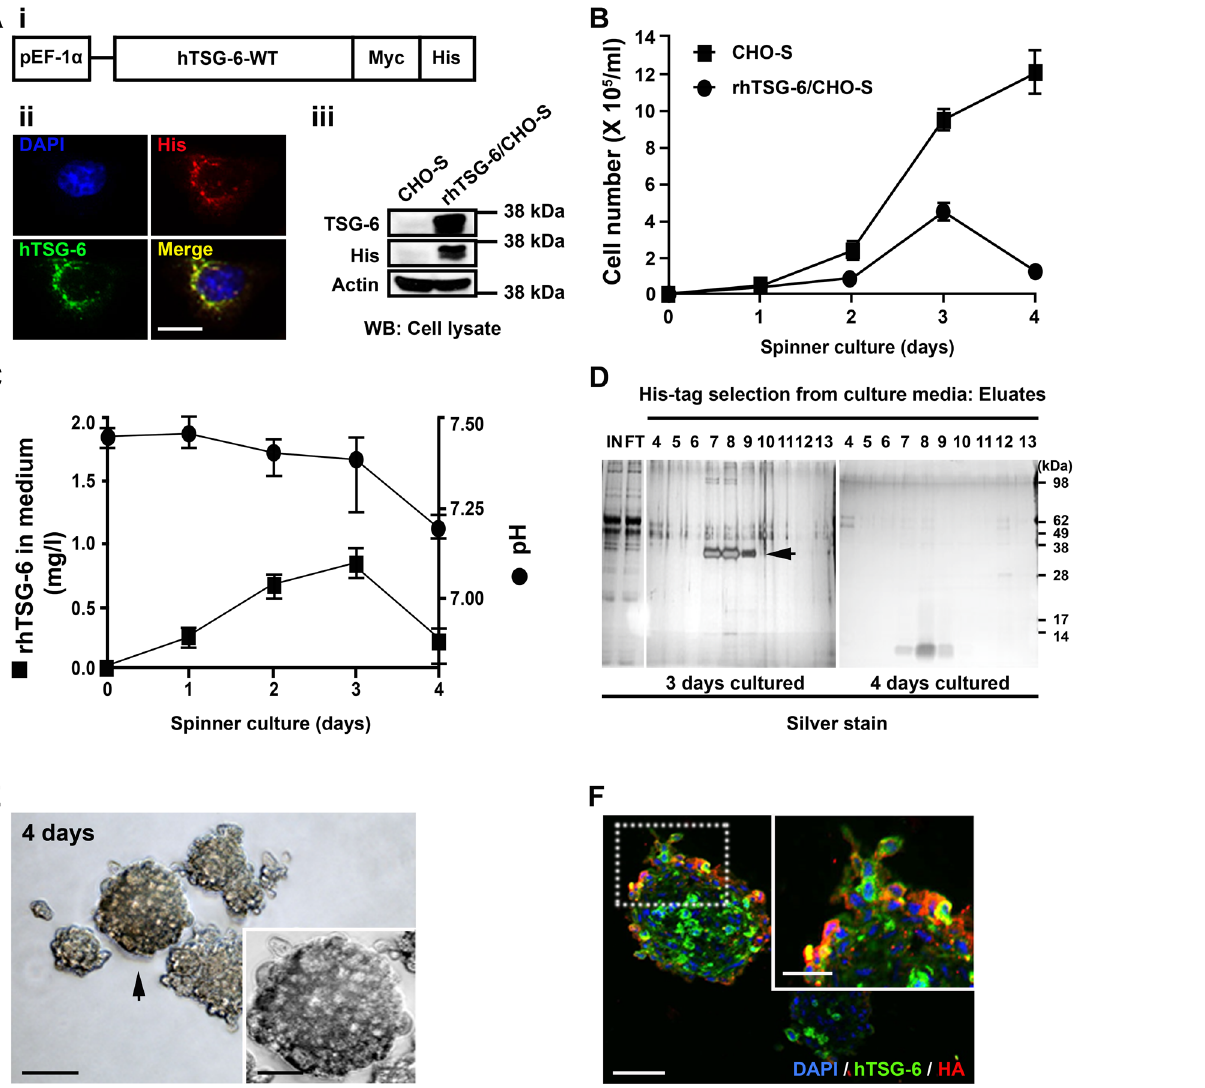
Fig 1. CHO cell line stably transfected to synthesize rhTSG-6 forms aggregates resulting in a decrease of protein production. Cells were incubated in CD CHO basal media and in spinner culture. (A i) Diagram of expression plasmid of TSG-6 under control of human elongation factor promoter 1 α and insertion of sequences for Myc and His tags at the C-terminus. (A ii) Expression of rhTSG-6 (antibody clone A38.1.20) and the His tag by immunocytochemistry. Scale bar = 10 μ m. (A iii) Expression by Western blotting. (B) Number of control CHO cells (CHO-S) and rhTSG-6 synthesizing cells (rhTSG-6/CHO-S). Data are presented as mean ± S.D. (C) rhTSG-6 content and pH of medium from cultures of rhTSG-6/CHO-S cells. Data are presented as mean ± S.D. (D) Western blots with antibodies to the His-tag of medium from cultures of rhTSG-6/CHO-S cells. Monomeric rhTSG-6 was detected after day 3 but not after day 4, apparently because of aggregation. Abbreviations: IN, input sample; FT, flow through. (E) Aggregates of rhTSG-6/CHO-S cells after 4 days of culture. Scale bars = 500 μ m and 250 μ m (insert). (F) Immunolabeling with rhTSG-6 antibody (clone A38.1.20), HABP (biotin-conjugated HA binding proteins), and DAPI staining of aggregates. Scale bars = 100 μ m and 50 μ m